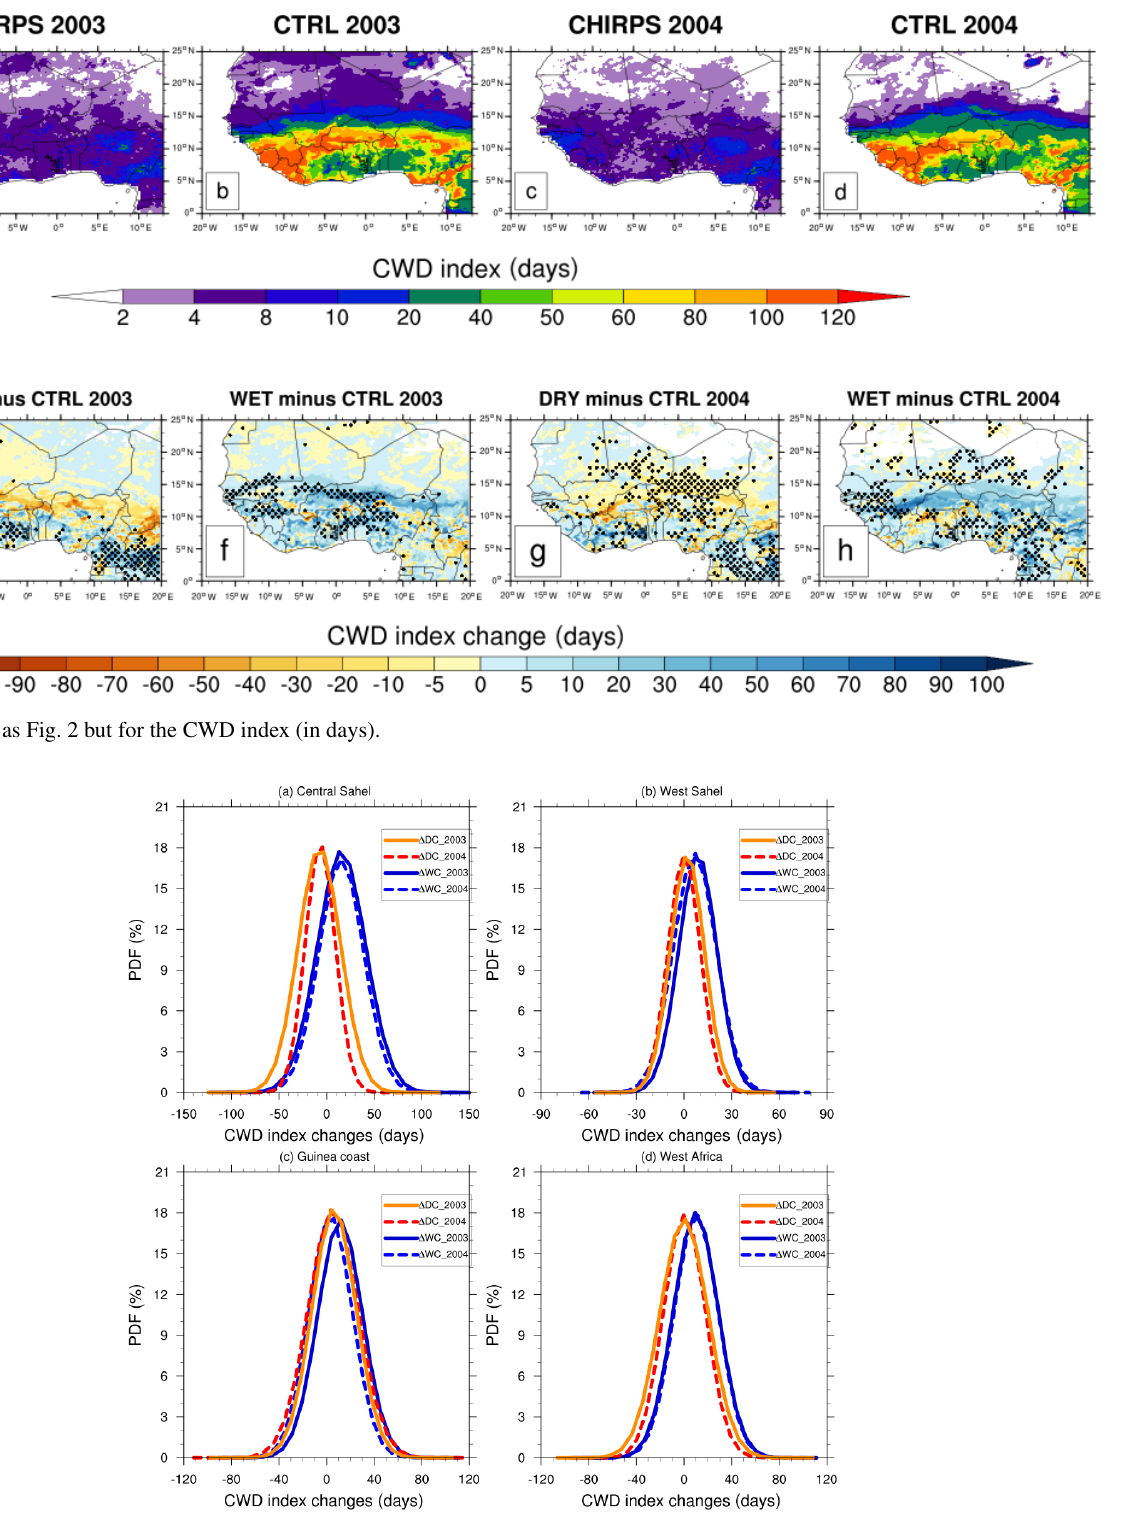
Figure 9. Same as Fig. 3 but for the CWD index (in